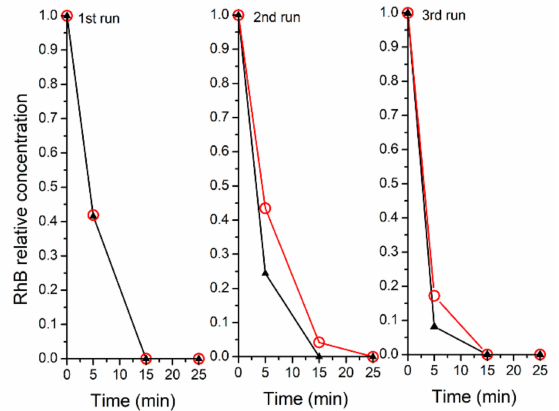
Figure 8. Cycling runs in the photodegradation of RhB in the presence of LDH1 (mg Ag / mL RhB = 0.30; red circle) and LDH3 (mg Ag / mL RhB = 0.15; black